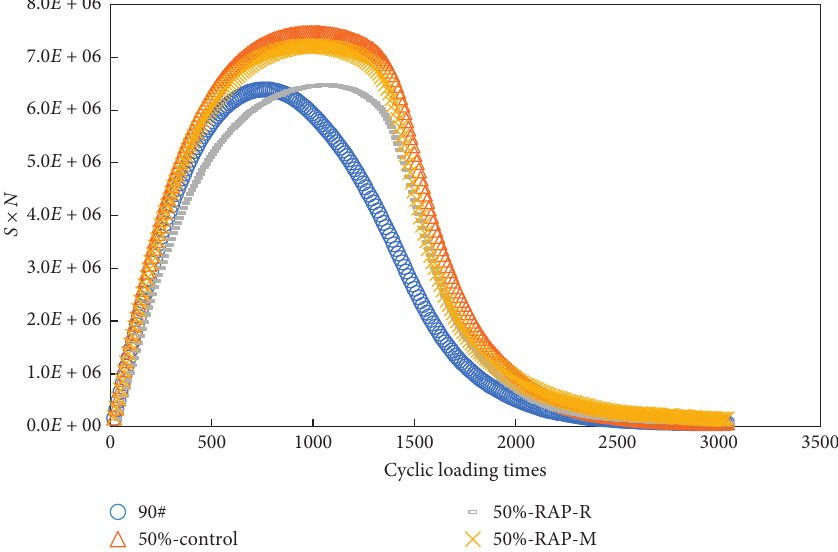
Figure 25: Relationship between S × N values and cyclic loading